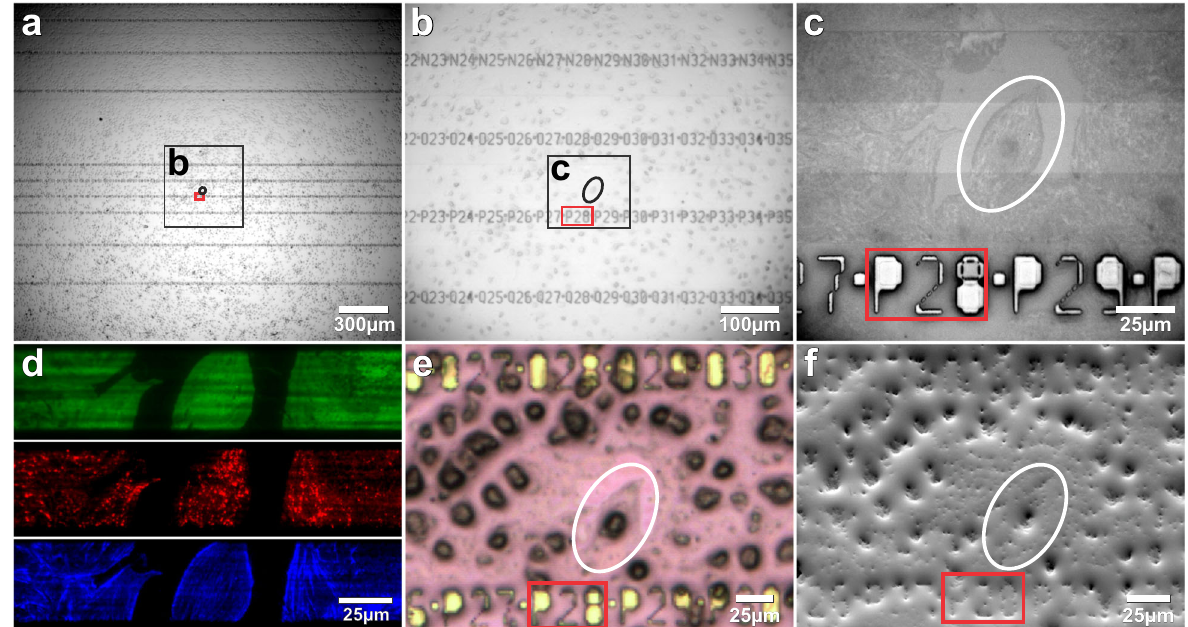
Fig. 2 Landmark visibility and localization of region of interest in LM and SEM. a – c Bright fi eld image of landmarked chip with LSECs, cell of interest with related landmarks under ( a ) 4×, ( b ) 20× and ( c ) 60× magni fi cation. d Chip-based TIRF image of cell membrane (green), protein undergoing endocytosis (red) and actin (blue). e Bright fi eld image after resin coating. f SEM image of processed sample inside the FIB-SEM with visible